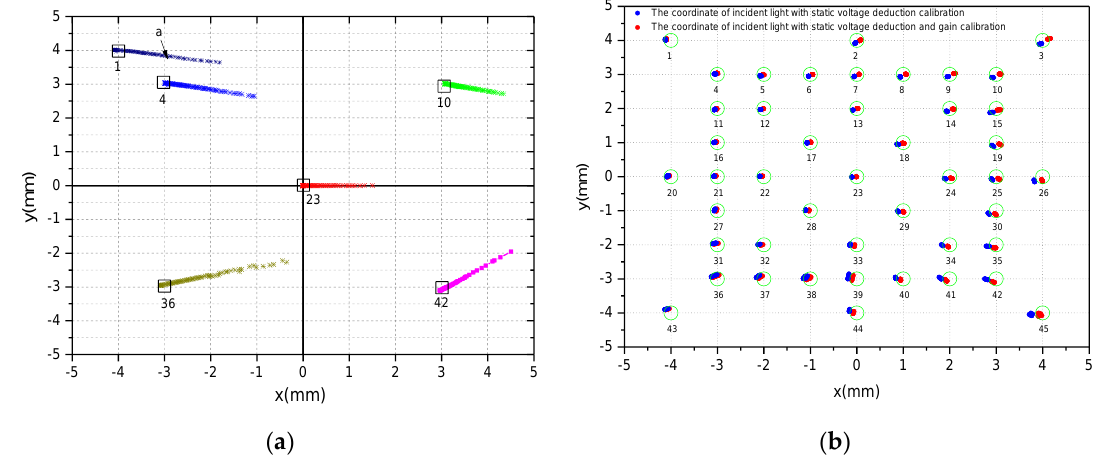
Figure 14. ( a ) The coordinates of sampling points without any calibration. ( b ) The blue coordinates with static voltage deduction calibration and the red coordinates with static voltage deduction and equalization gain calibration.